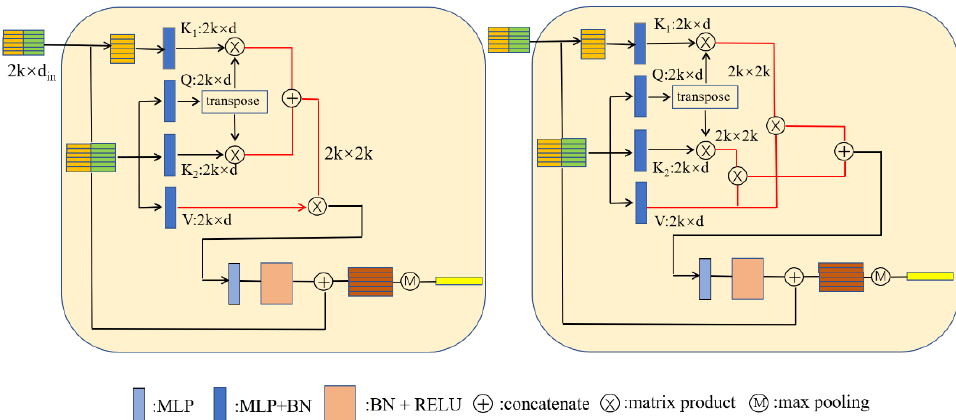
Figure 5. Improved transformer structure. ( Right ): the two attention weight matrices added. ( Left ): the two attention weight matrices fused at the feature level. The red line indicates the difference between them.